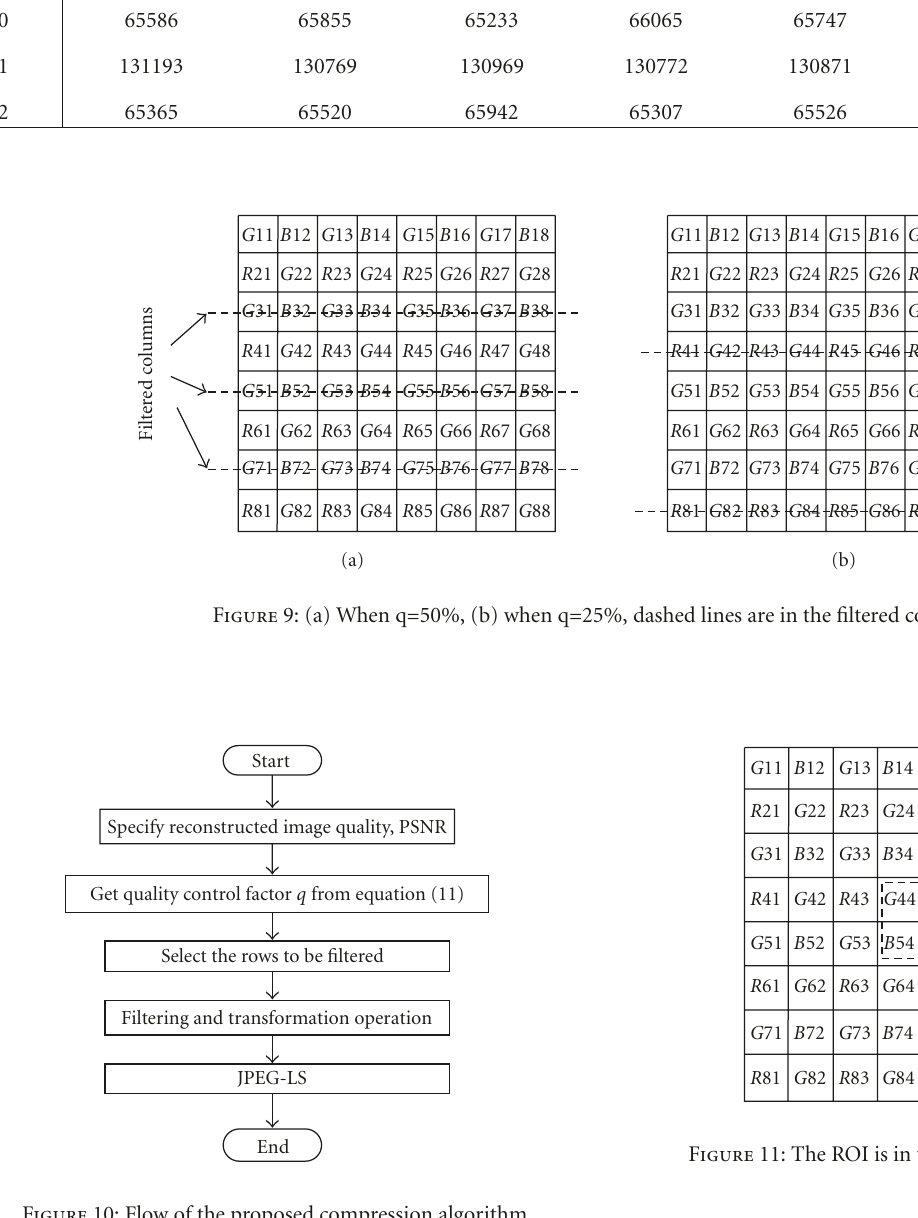
Figure 10: Flow of the proposed compression algorithm.